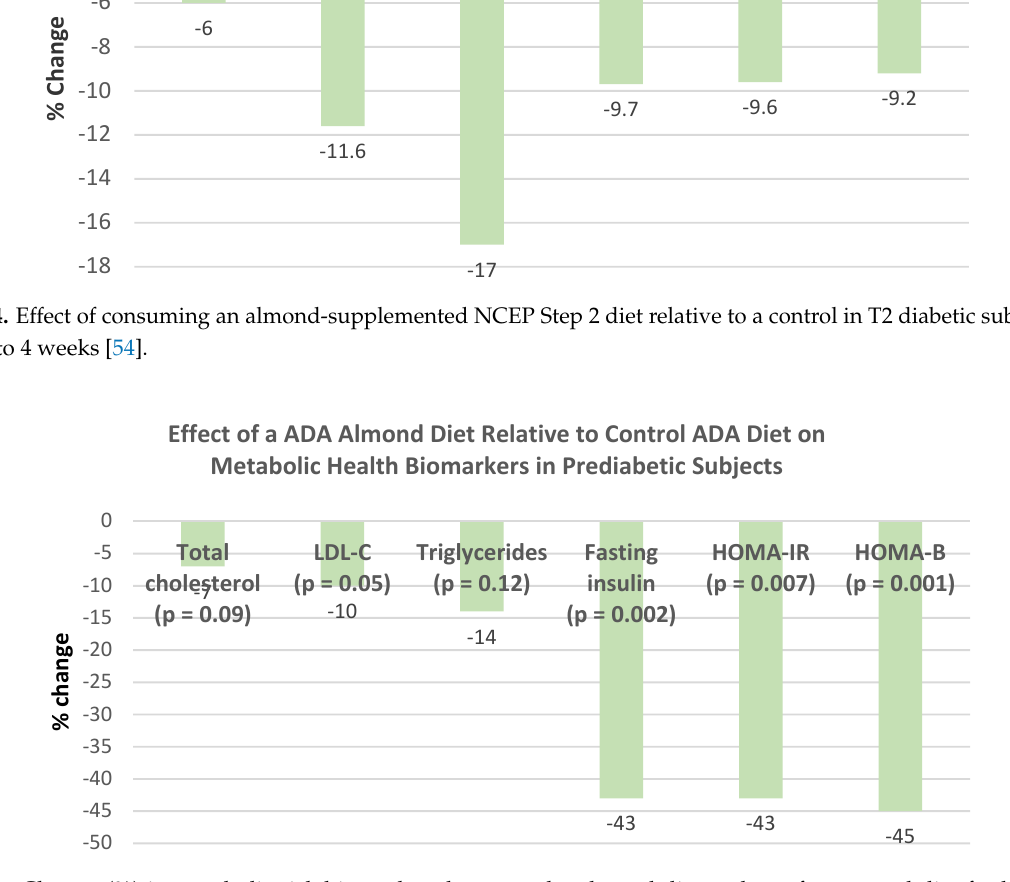
Figure 35. Change (%) in metabolic risk biomarkers between the almond diet and nut-free control diet for baseline to 16 weeks during a weight maintenance diet in prediabetic individuals [62].